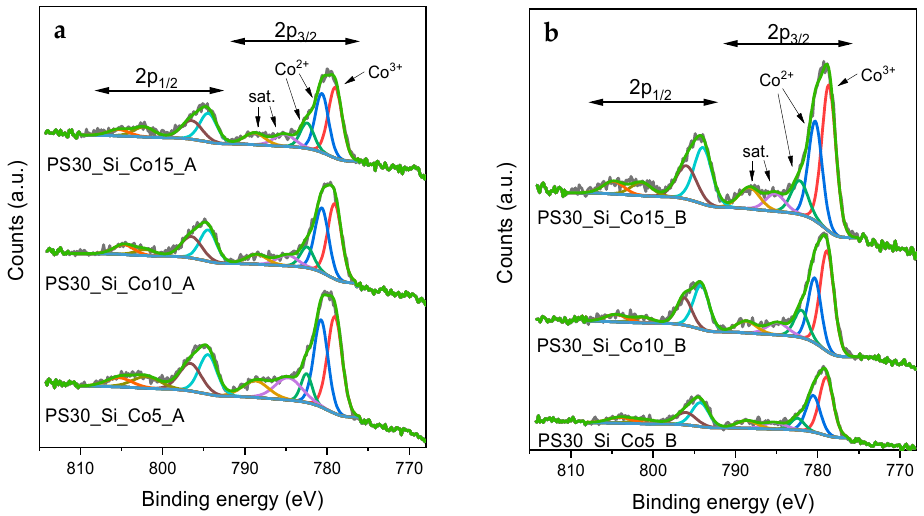
The surface composition of the Co-loaded materials synthesized in the paths A and B was more precisely characterized by X-ray photoelectron spectroscopy (XPS). The high- resolution XPS spectra recorded in the Co 2p region (Figure 6a,b) display a characteristic doublet of the Co 2p 3/2 and Co 2p 1/2 peaks, which is related to the spin-orbital splitting. The determined distance between the peaks in this doublet for all studied materials is Δ = 15.3–15.4 eV, which is the typical value reported for the Co 3 O 4 phase in the literature [36,37].